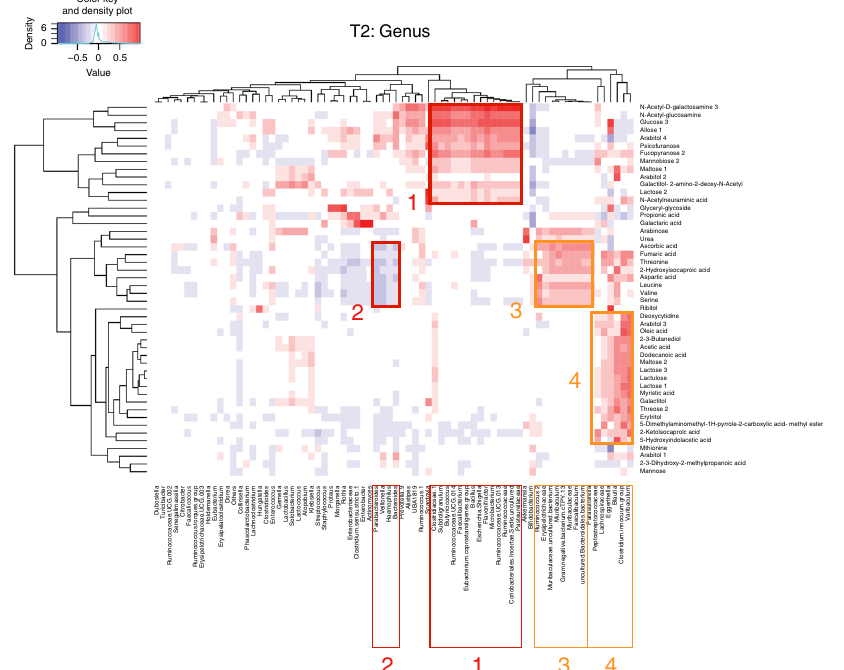
Fig. 5 Microbe – metabolite correlation heatmap showing associations between bacterial genus and the ANOVA and VIP-score-selected metabolites. Spearman correlation coef fi cients were calculated for pairwise combinations of microbial abundances at the genus level (from 16S rRNA gene sequencing data) and metabolite intensities. In red boxes are reported clusters of metabolites either enriched (box 1) or reduced (box 2) in vaginally delivered breastfed infants. Box 2 metabolites are associated with genera highly abundant in breastfed infants; in orange boxes (3 and 4) are highlighted clusters of metabolites that are enriched in formula S-fed infants. The corresponding genera correlating with these metabolites are also highlighted with the same colour and numbering